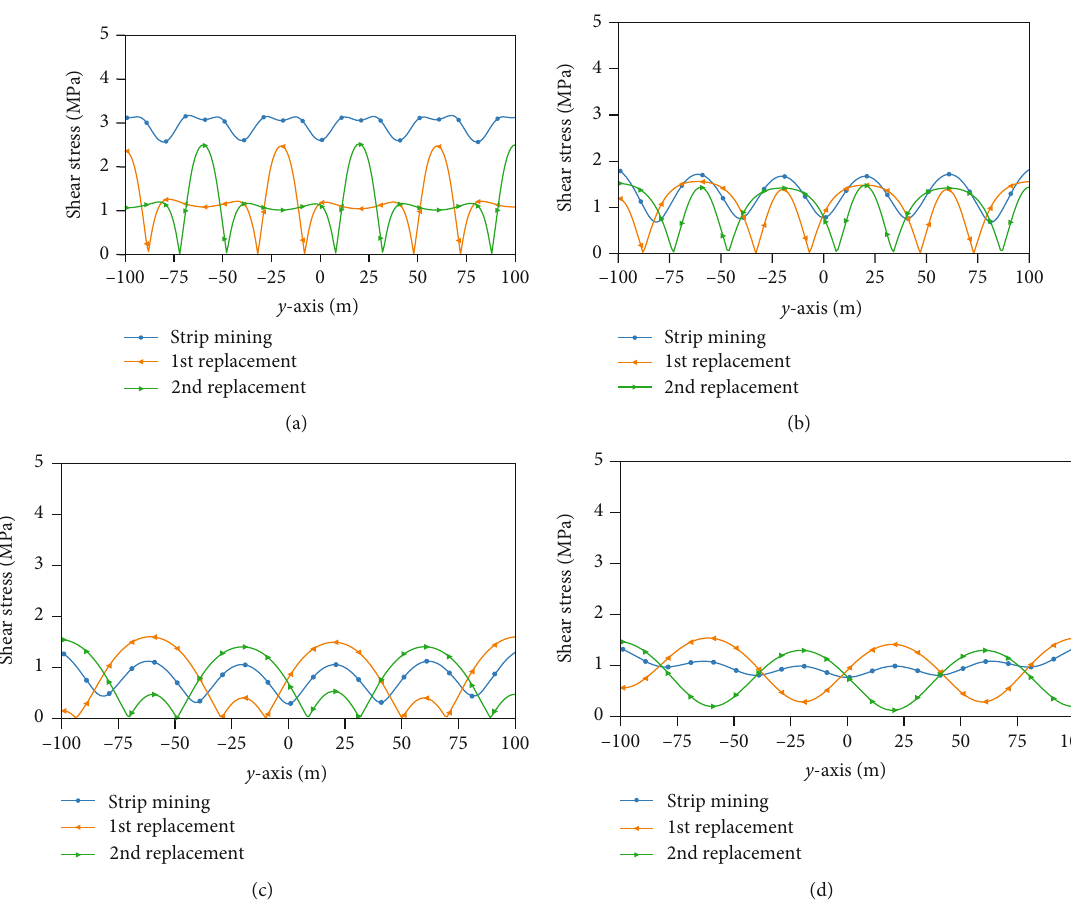
Figure 11: Characteristics of shear stress distribution at various depths: (a) depth of 10 m, (b) depth of 20m, (c) depth of 30m, and (d) depth of 40